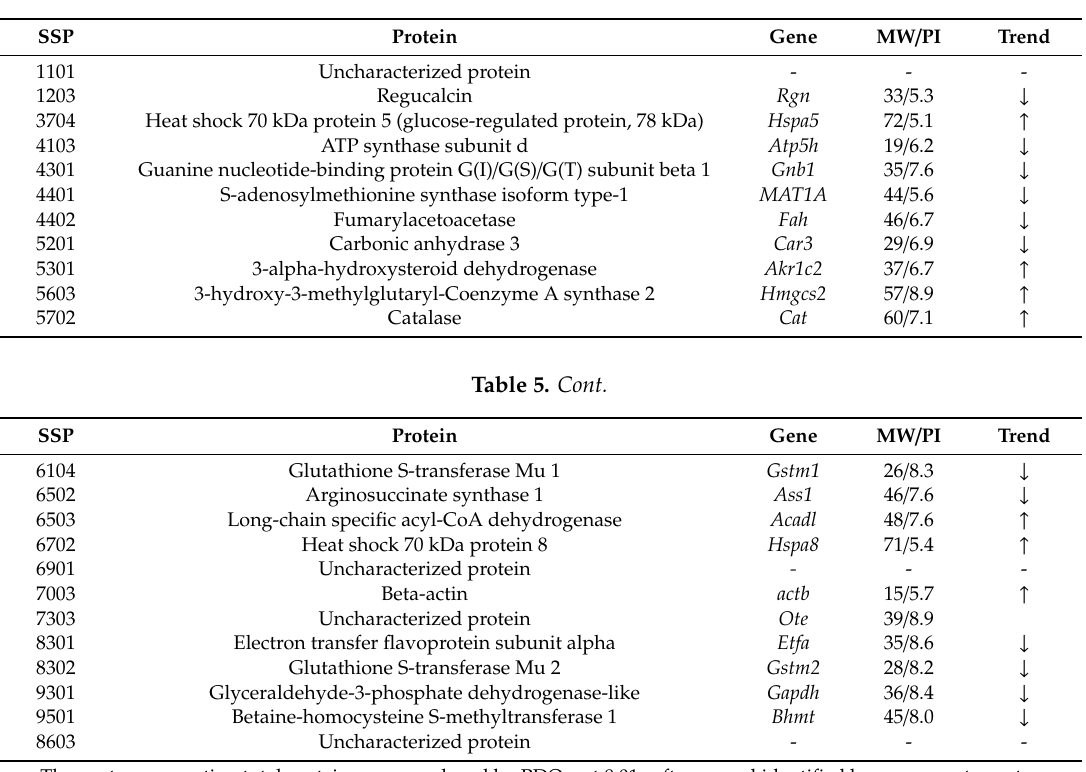
Table 5. Di ff erent proteins expression in chicken liver.